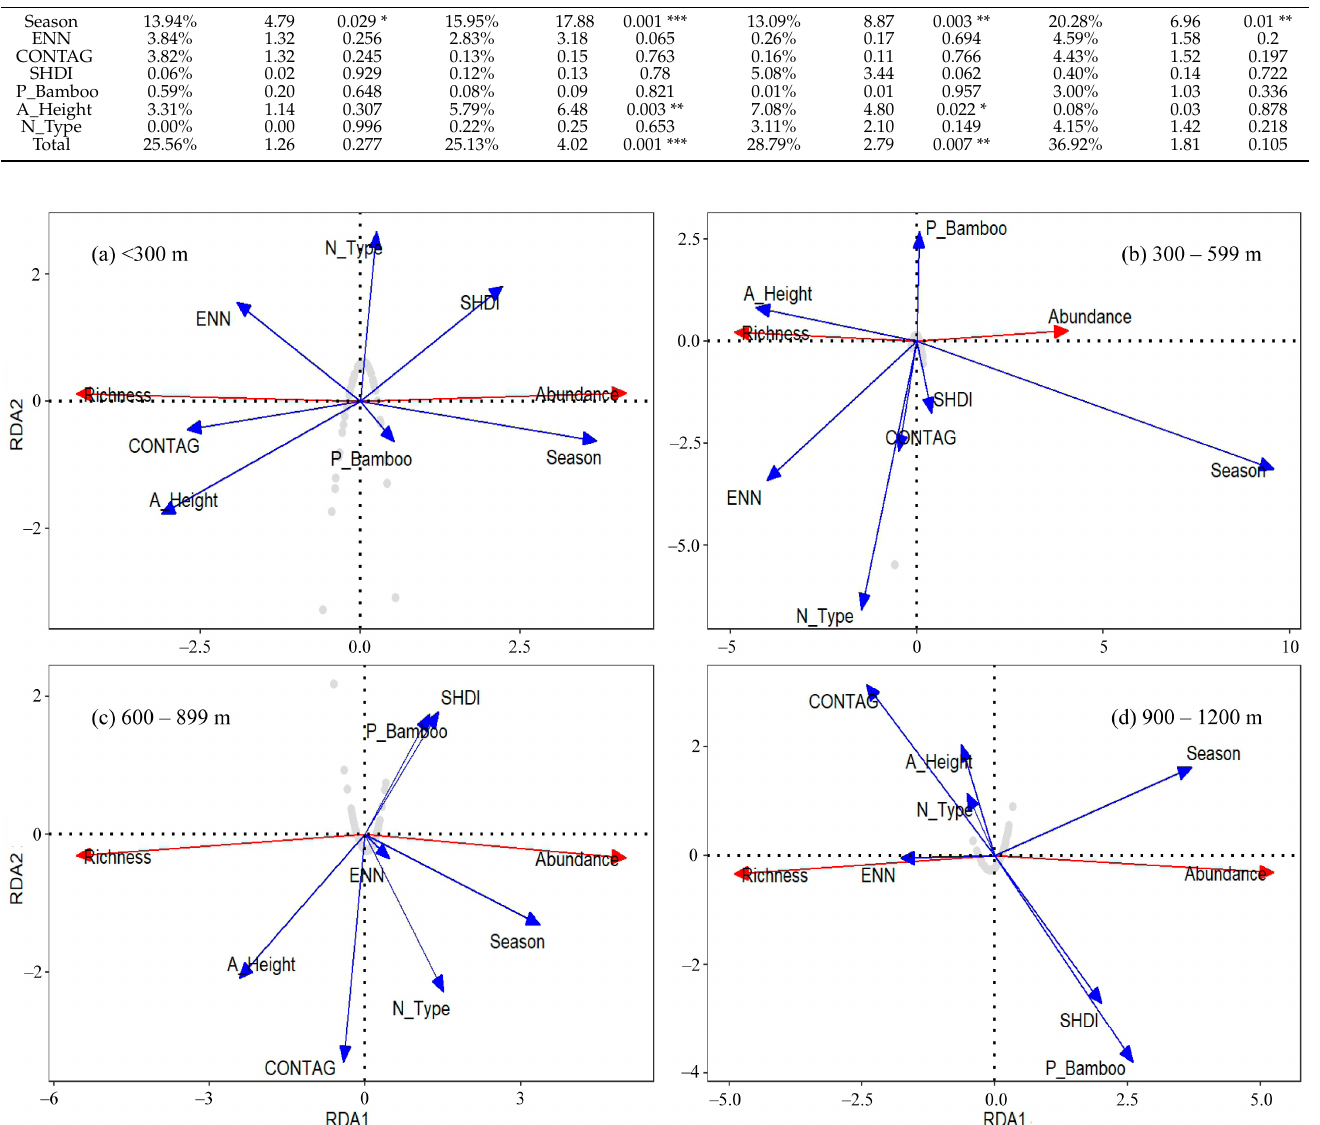
Figure 3. The result of redundancy analysis (RDA): all bird species richness and abundance with an explanatory variable during the four altitude gradients (<300 m, 300–599 m, 600–899 m, 900–1200 m). Gray point is the survey transect. SHDI is Shannon–Wiener landscape diversity index; A_Height is the average canopy height; P_Bamboo is percentage of bamboo; ED is edge density index; ENN is Euclidean nearest-neighbor distance index; CONTAG is contagion index; N_Type is the number of land cover types.